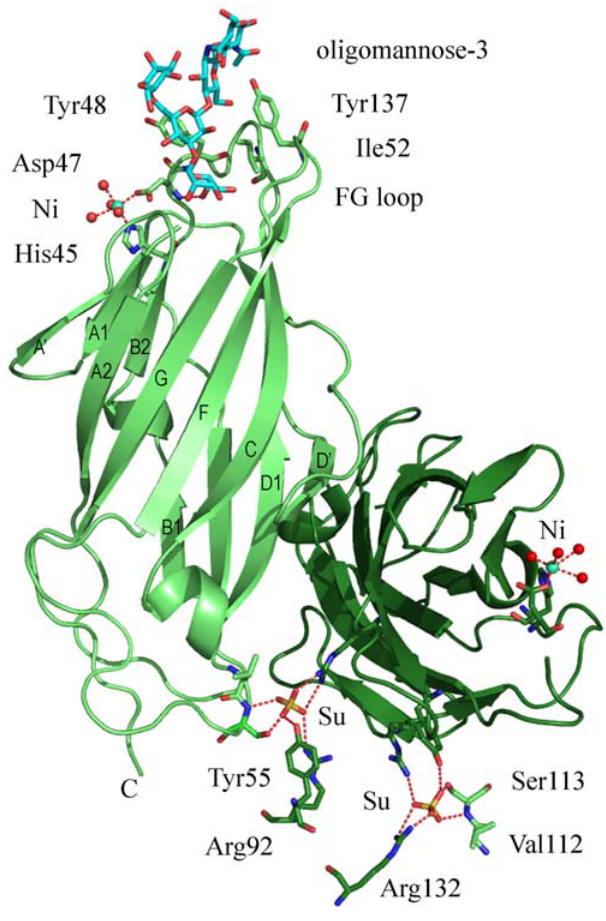
Figure 2. Crystal structure of FimH in complex with oligoman- nose-3. The two FimH RBDs related by non-crystallographic symmetry (green and forest-green, Ig-fold labeling) both bind oligomannose-3 (only one is shown in blue cyan), interconnected via Asp47 to a nickel ion (green cyan). His45 and Asp47 and four waters ligate the nickel ion in an octahedral configuration. Sulphate ions (yellow with red oxygens) stabilize a highly charged crystal packing interface by bridging Val112 and Ser113 with Arg132 from the two crystallographically independent RBDs with Arg92 and Tyr55 from a symmetry-related RBD.